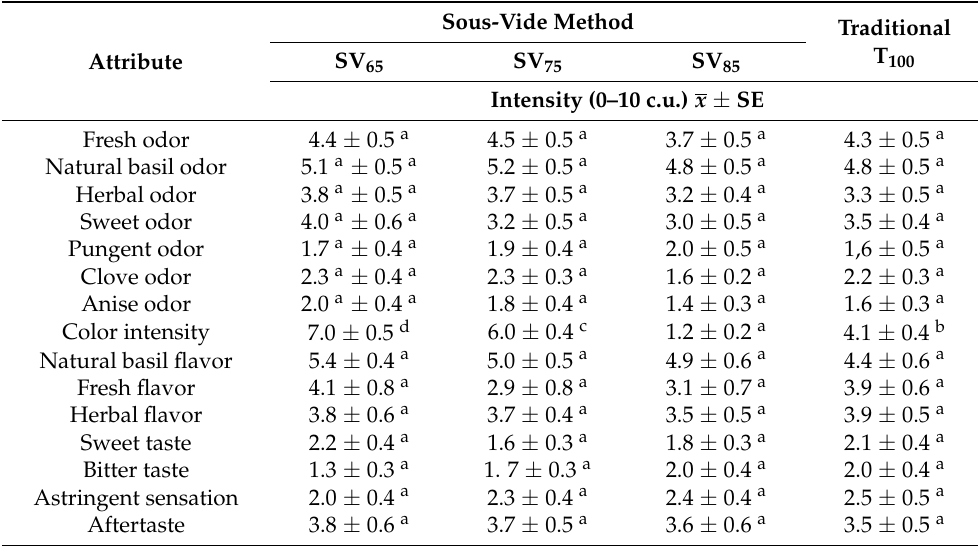
Table 2. Effect of various heat treatment methods on the sensory profile of basil infusions. Sous-Vide Method Attribute